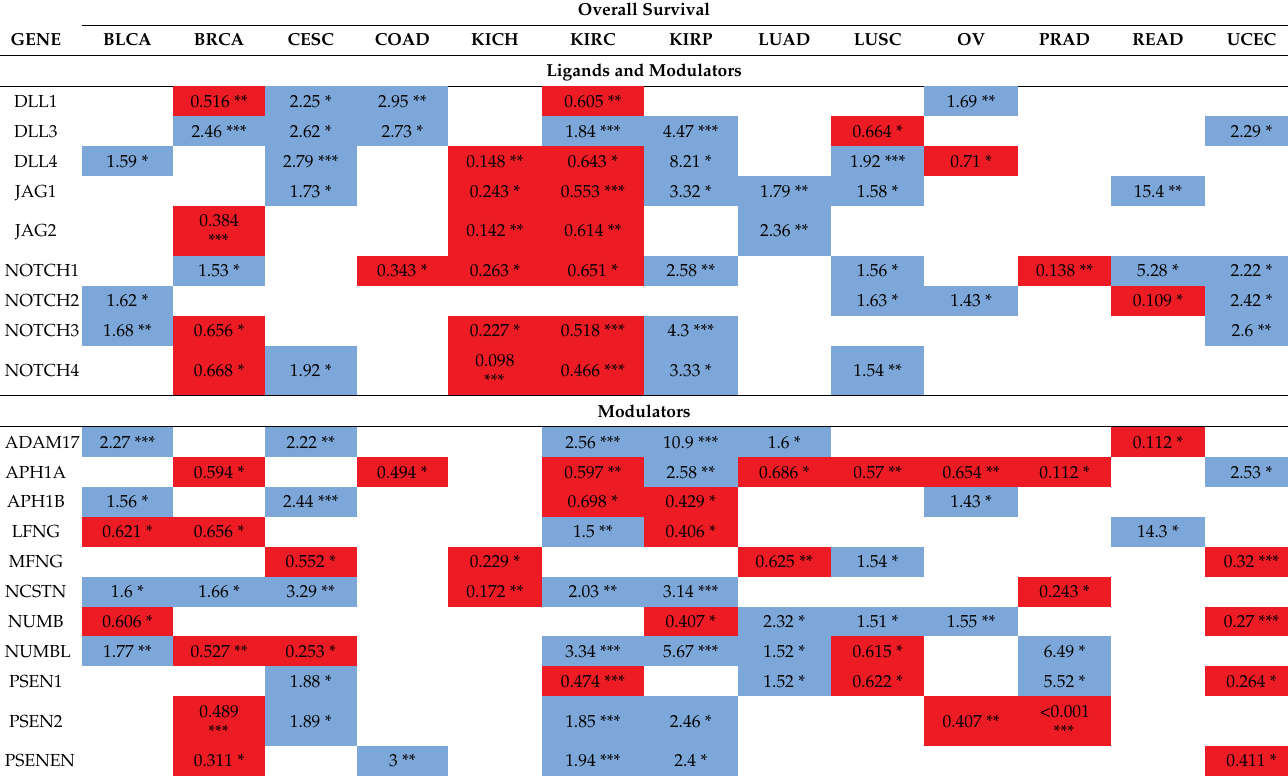
Table 3. Prognostic effect of the chosen Notch pathway members on OS in the analyzed tumors. Value represents HR with statistical significance, and the color indicates expression level correlated with favorable prognosis: red—higher expression favorable, blue—lower expression favorable (level of the expression is considered relative to the determined